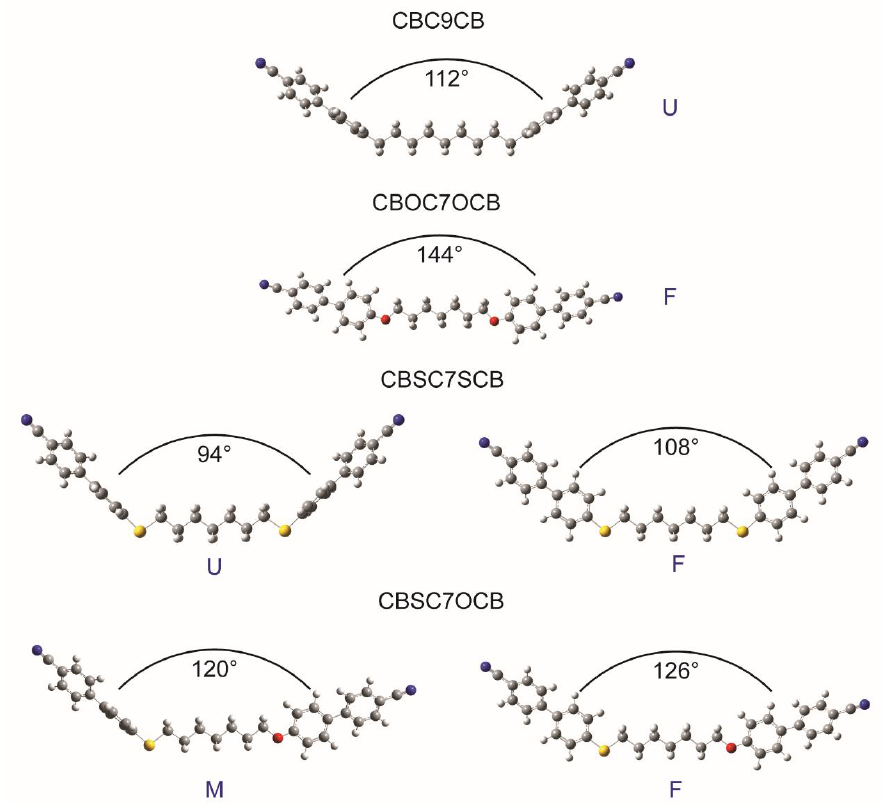
Figure 1. ( a ) The calculated potential energy functions for the torsional motion of the cyanobiphenyl dimers relative to the minimum value ( φ 1 or φ 2 ); black solid line — CBC9CB dimer, red solid line —